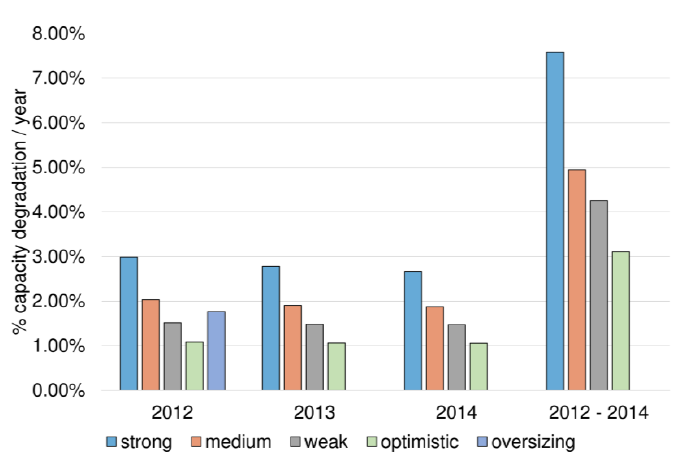
Figure 13. BESS sizing influence on aging effects.